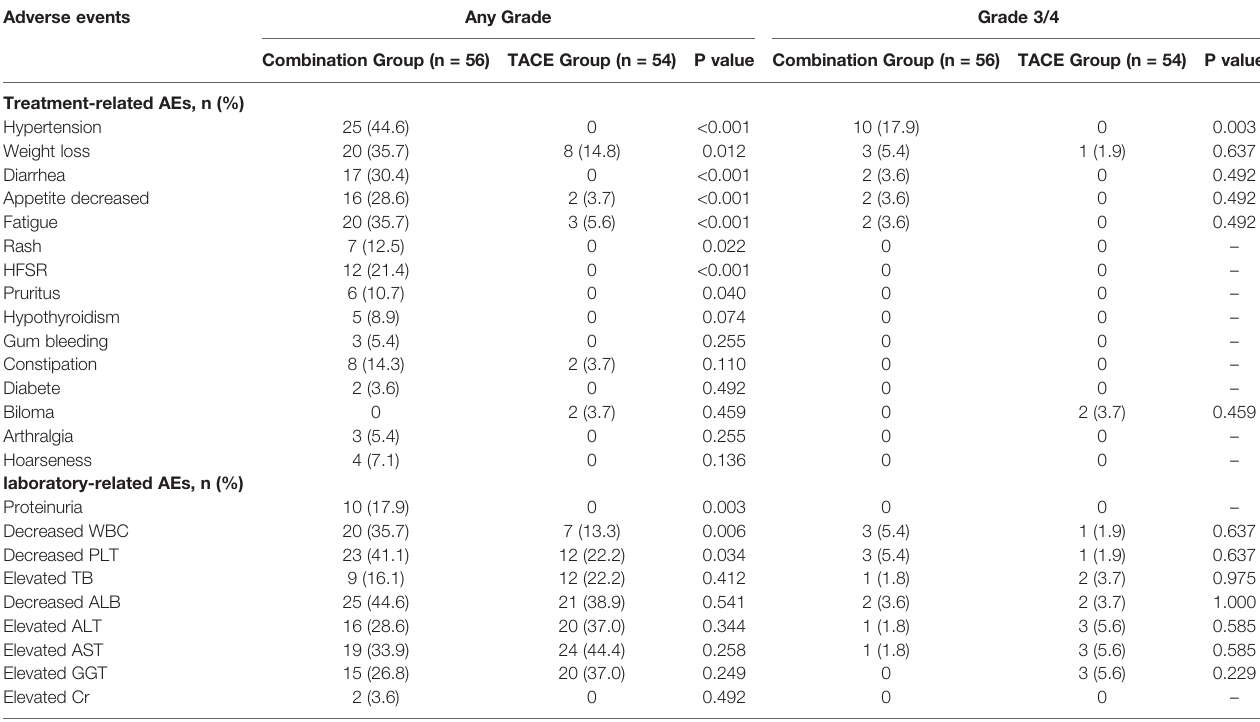
TABLE 6 | Treatment-related adverse events. Adverse events Any Grade